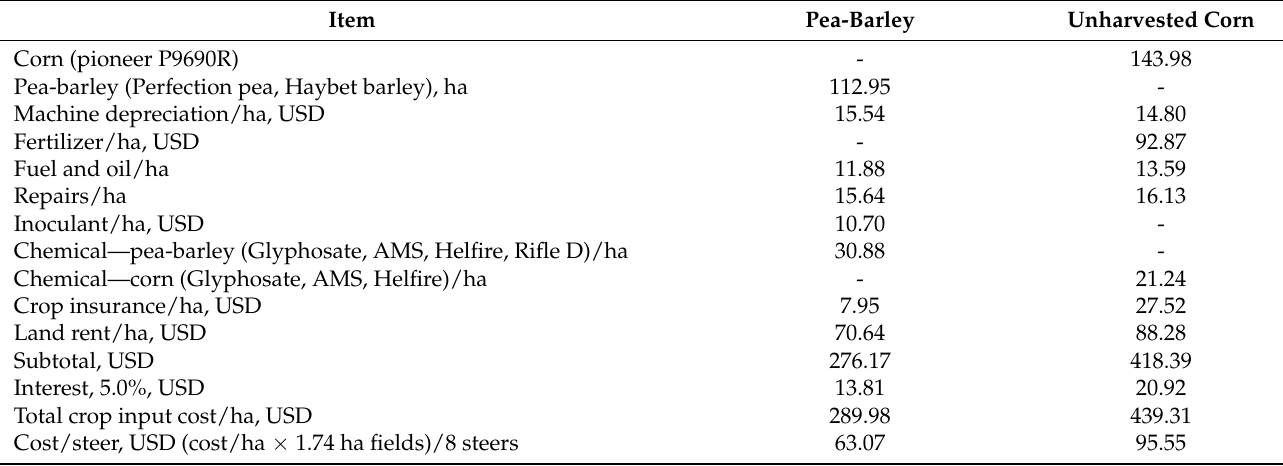
Table 4. Farming input costs for beef steer annual forage grazing 1,2